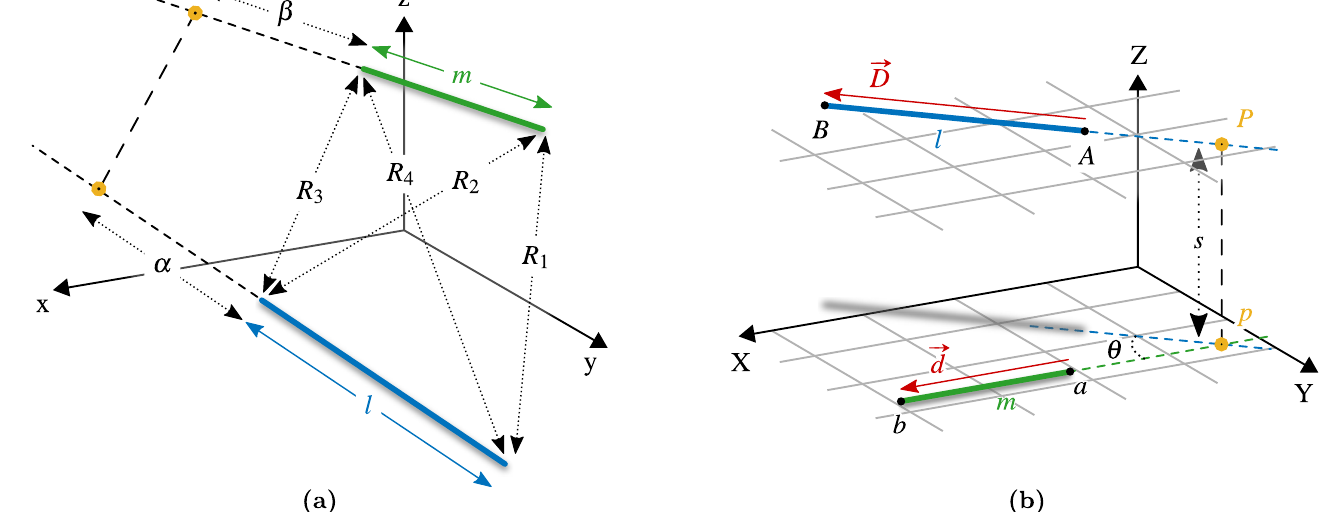
Figure 4. ( a ) Two straight filaments at any angle. For convenience, l is considered the transmitting filament which generates a magnetic field, m is the receiving filament, where a voltage is induced by the variable field. ( b ) A change in coordinates is performed in order to calculate the mutual inductance between the two